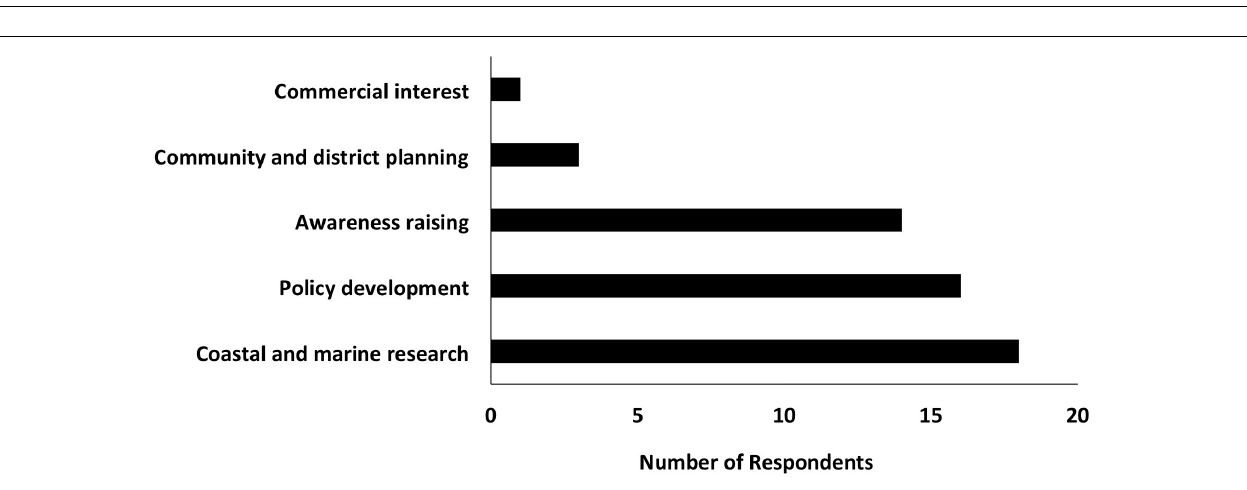
FIGURE 5 | Survey respondent use of the